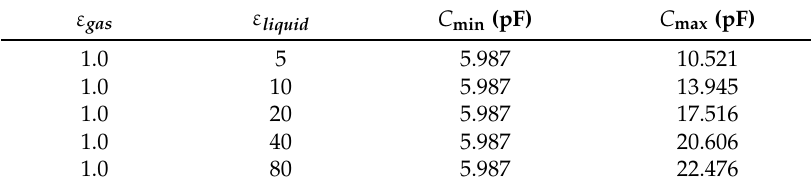
Figure 5. The effect on (cid:1829) (cid:3015),(cid:3033)(cid:3032)(cid:3040) due to variation of ε (cid:3039)(cid:3036)(cid:3044)(cid:3048)(cid:3036)(cid:3031) .